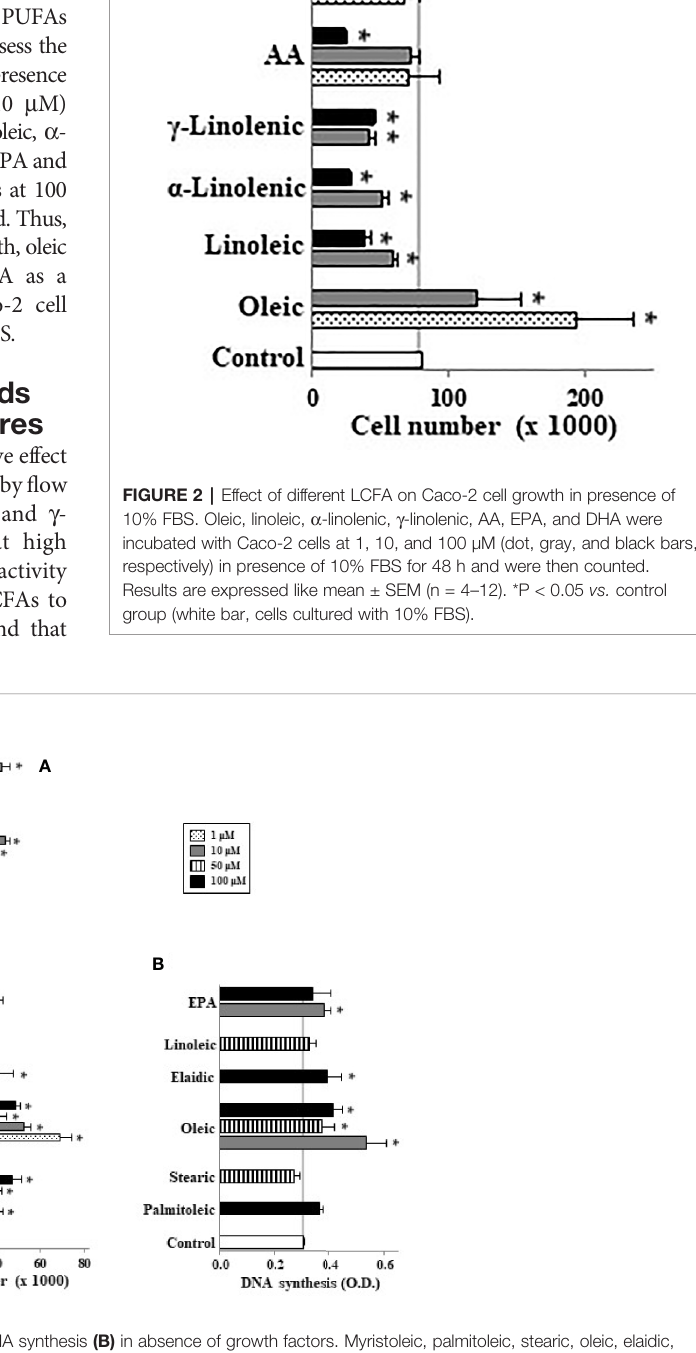
FIGURE 1 | Effect of different LCFA on Caco-2 cell growth (A) and DNA synthesis (B) in absence of growth factors. Myristoleic, palmitoleic, stearic, oleic, elaidic, linoleic, a -linolenic, g -linolenic, mead, AA, EPA, erucic, and DHA were incubated with Caco-2 cells at 1, 10, 50, and 100 µM (dot, gray, line, and black bars, respectively) without FBS for 48 h and were then counted or DNA synthesis measured by cell BrdU incorporation. Results are expressed like mean ± SEM (n = 8 – 30). *P < 0.05 versus control group (white bar, cells cultured without FBS).